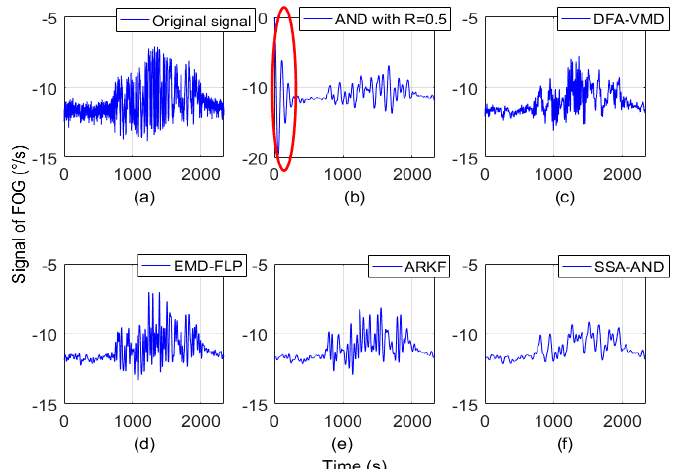
Figure 5. Comparison results of different de-noising methods for the signal of FOG1: ( a ) original signal; ( b ) signal de-noised by AND with R = 0.5, the red circle shows the signal delay happens when using AND; ( c ) signal de-noised by DFA-VMD; ( d ) signal de-noised by EMD-FLP; ( e ) signal de-noised by ARKF; ( f ) signal de-noised by SSA-AND. AND: augmented nonlinear differentiator; DFA-VMD: detrended fluctuation analysis-variational mode decomposition; ARKF: adaptive robust Kalman filter; EMD-FLP: empirical mode decomposition-forward linear prediction; SSA-AND: singular spectrum analysis-augmented nonlinear differentiator.